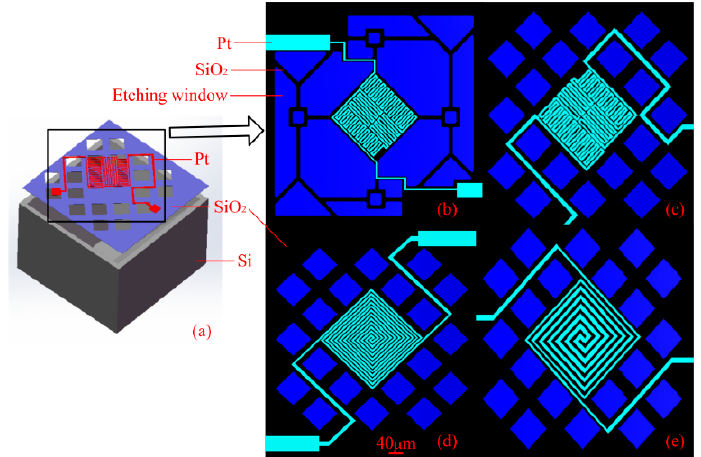
Figure 5. ( a ) The overall structure of the micro-hotplate, ( b – e ) Micro-hotplates with four different structures [32].